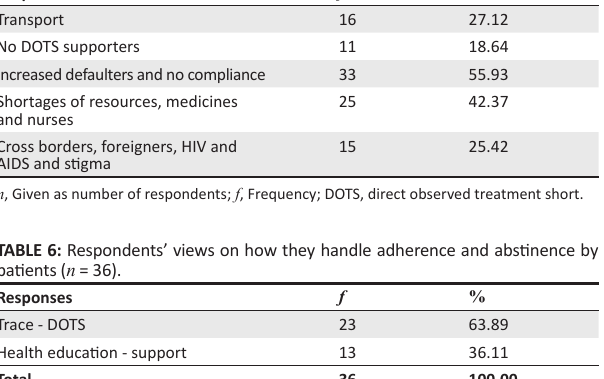
TABLE 5: Respondents’ views on the five biggest problems preventing community nurses from fulfilling their role in the prevention of tuberculosis ( n = 59). Responses